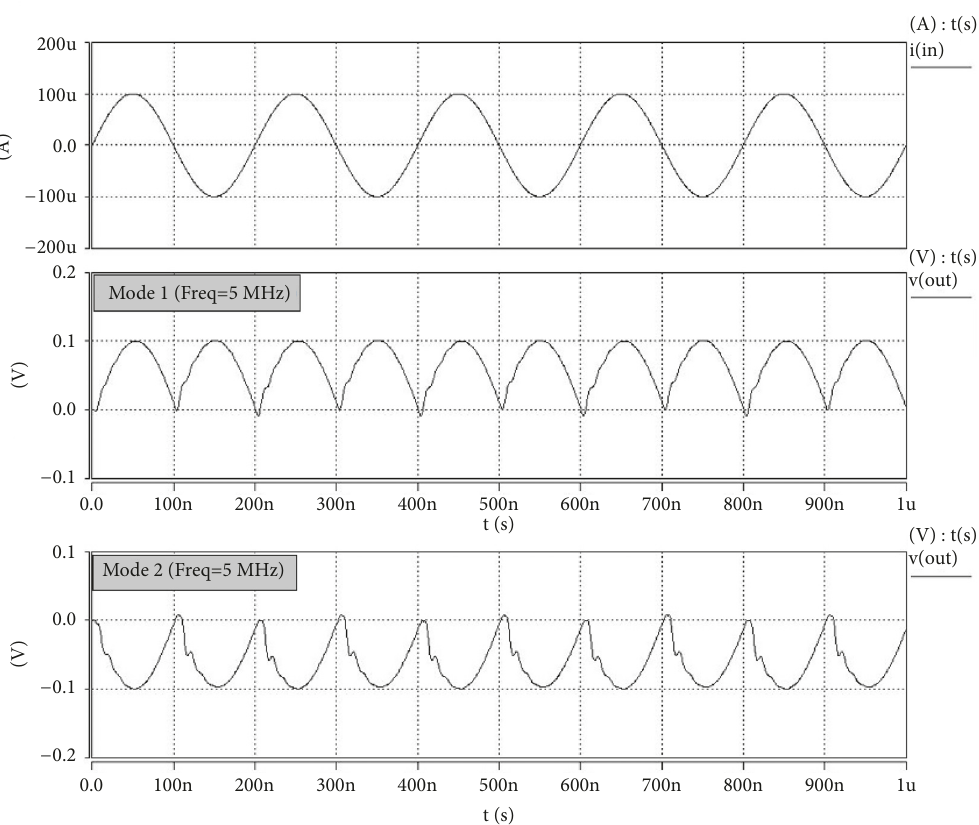
Figure 10: Simulation results of the input and rectified output waveforms of the circuit (Figure 4) at various frequencies for an input signal with an amplitude of 100 𝜇 A.